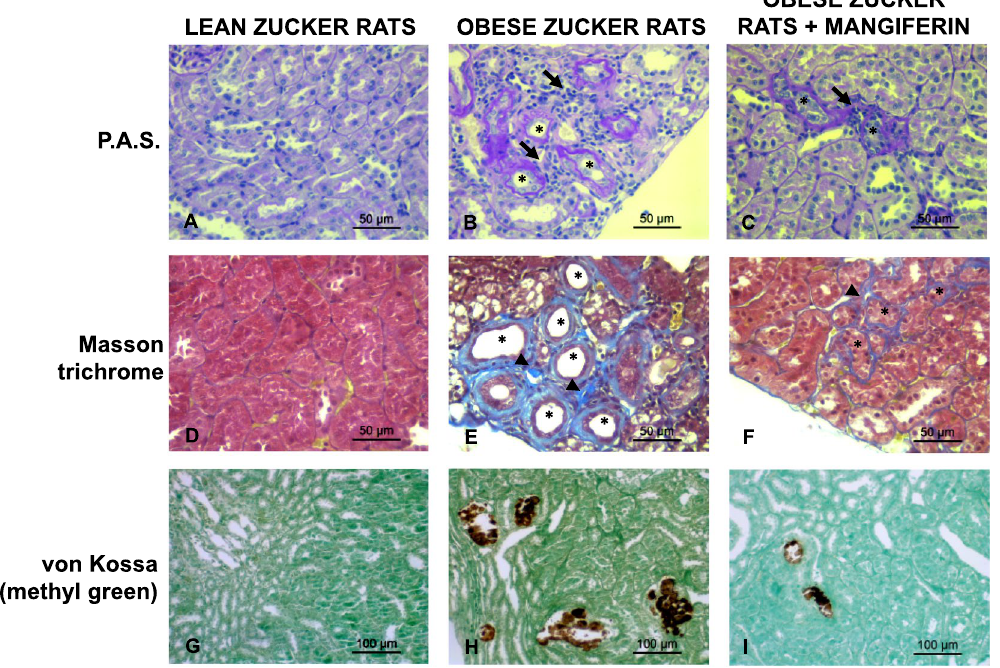
Figure 6. Treatment with Mangiferin reduces renal injury in obese Zucker rats. Kidney tissue samples from Lean, Obese Zucker rats and Obese Zucker rats plus 8 weeks of mangiferin treatment were analyzed with PAS stained sections ( A–C ) where tubular atrophy (asterisks) and peritubular inflammatory infiltrate (arrows) were observed. The thickening of the basement membrane was also evidenced in atrophic tubules (asterisks) with the Masson Trichrome, as well as interstitial fibrosis (arrowheads) ( D–F ). Mineral deposits are depicted by the brown color in von Kossa stain ( G–I ). Magnification: x400, scale Bar: 50 µ m for PAS and Masson Trichrome, x200 and scale bar 100 µ m for von